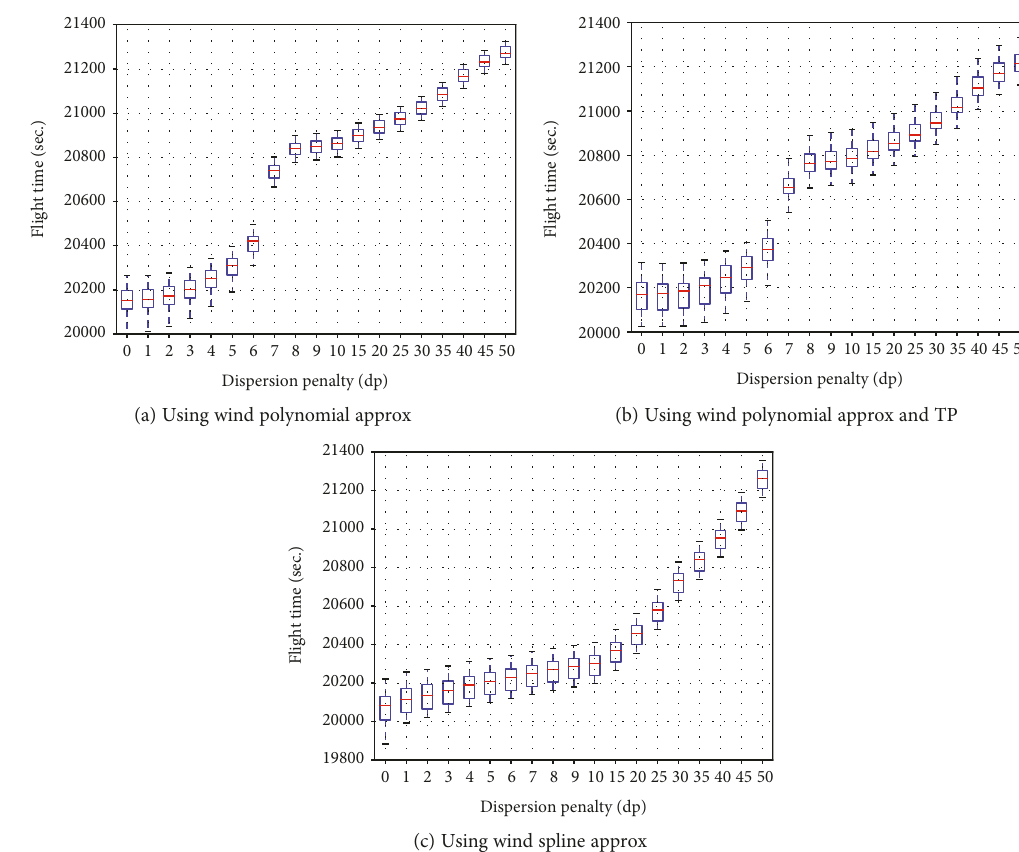
Figure 4: Optimal paths (for di ff erent dp